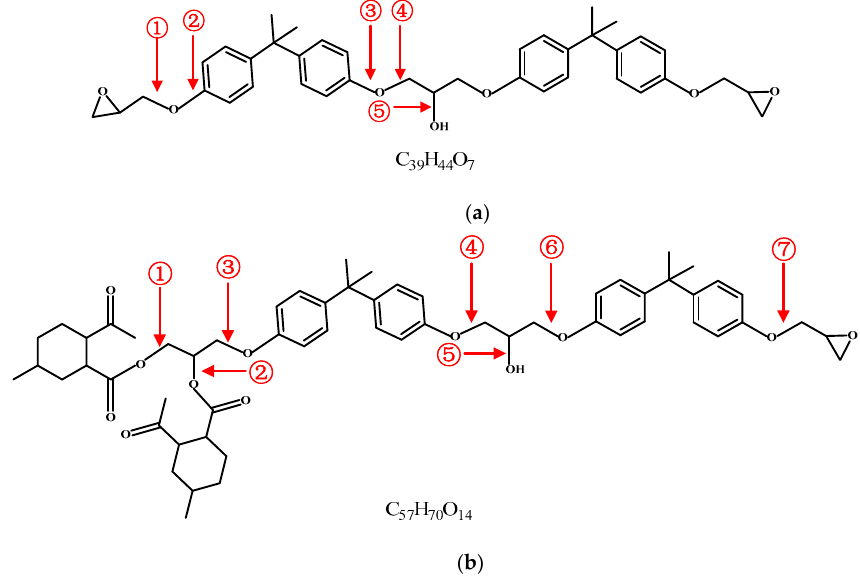
Figure 1. Structure of epoxy resin. ( a ) Structure of pure epoxy resin; ( b ) Structure of epoxy resin cured by anhydride.